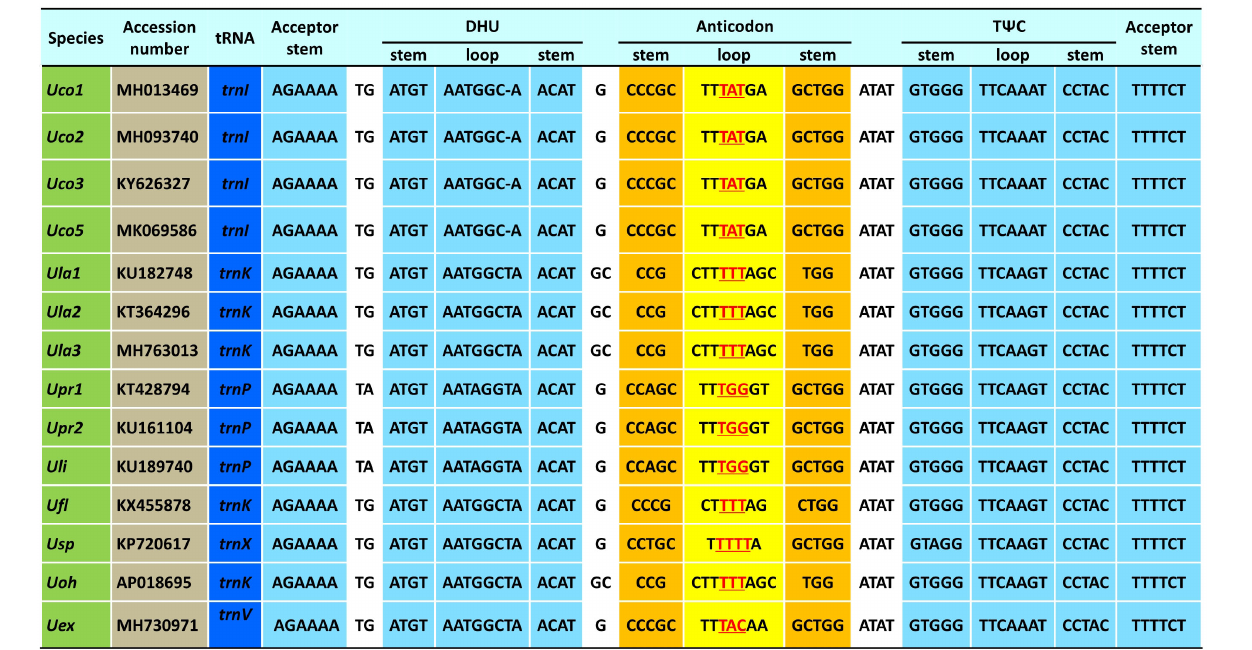
Frontiers in Marine Science |